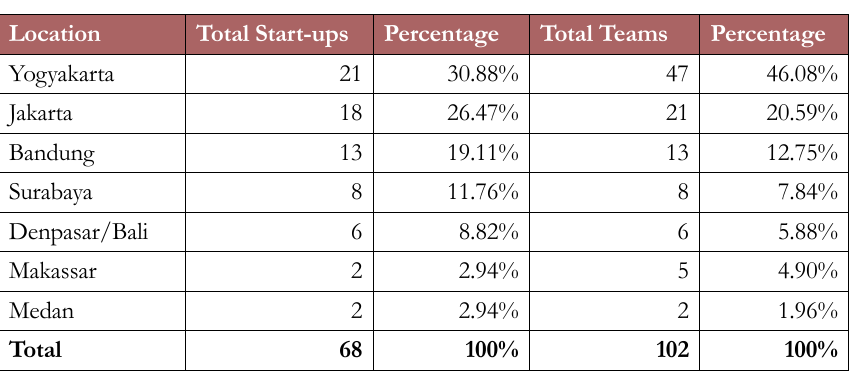
Table 5. Head Offices of Start-up Firms